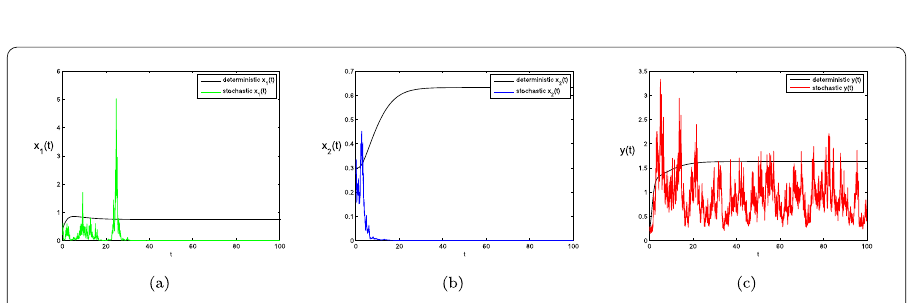
Figure 4 Solutions of stochastic system (3.1) with σ 1 = 1.5, σ 2 = 0.6, σ 3 = 0.7 show that x 1 and x 2 go to extinct but y persists. ( a ) The solution of x 1 ( t ); ( b ) the solution of x 2 ( t ); ( c ) the solution of y ( t )